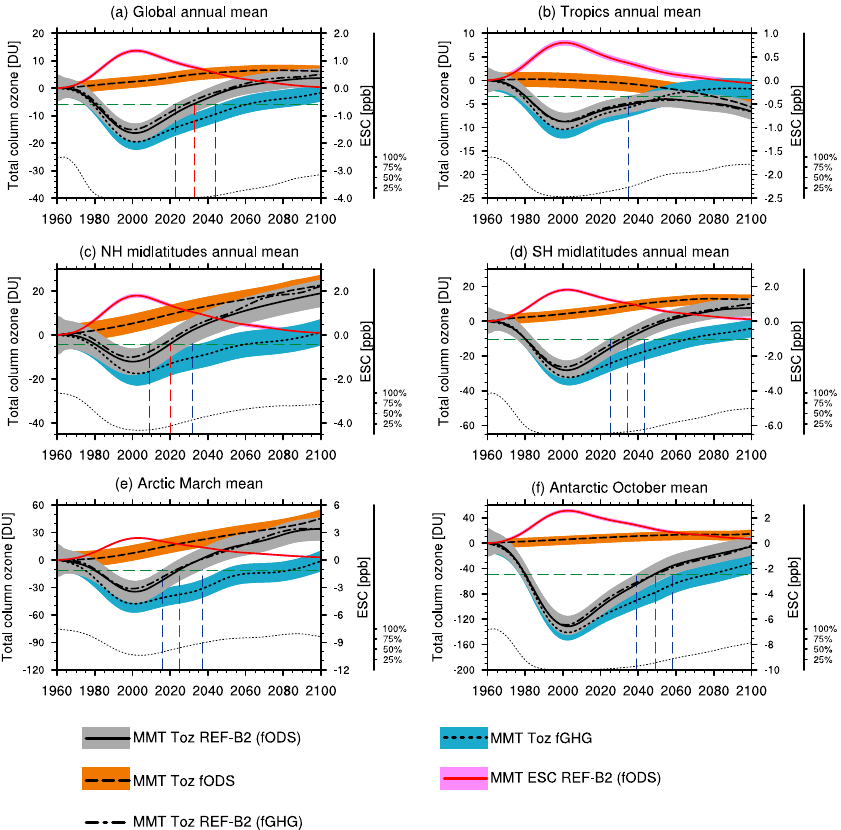
Fig. 6. 1960 baseline-adjusted total column ozone projections and 95% confidence interval for the multi-model REF-B2 trend which is in the one case derived from the models that performed the fODS simulation ( MMT O3 REF-B2(fODS) ; black line and grey shaded area) and in the other case from the models that performed the fGHG simulation ( MMT O3 REF-B2(fGHG) ; black dashed-dotted line). Also shown is the multi-model trend plus 95% confidence interval for fODS (black dotted line and orange shaded area), fGHG (black dashed line and blue shaded area), and ESC ( MMT ESC REF-B2(fODS ; red solid line and light red shaded area). The different panels show (a) global